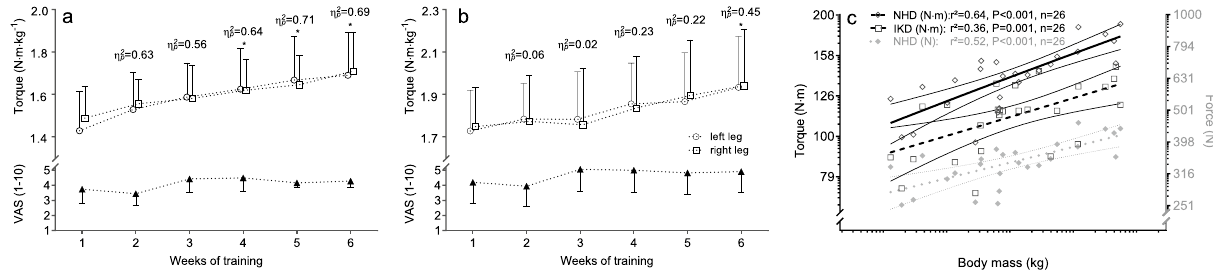
Figure 2. Time course of changes in body mass normalised eccentric knee flexor torque and muscle soreness measures on the dynamometer (IKD) ( a ) and Nordic hamstring device (NHD) ( b ) and body mass plotted against torque (IKD) and force (NHD) values ( c ). Average weekly soreness measured using a numeric visual analogue scale (VAS) (1–10) at the beginning of each training session. Values are mean ± 95%CI. * p < 0.05 (Bonferroni-corrected) versus the average torque of the first intervention week. Data points of body mass were obtained from the baseline characteristics of the recruited subjects. The linear regressions and their 95% confidence limits indicate that body-mass-correlate with the peak eccentric torque (IKD) and peak eccentric force